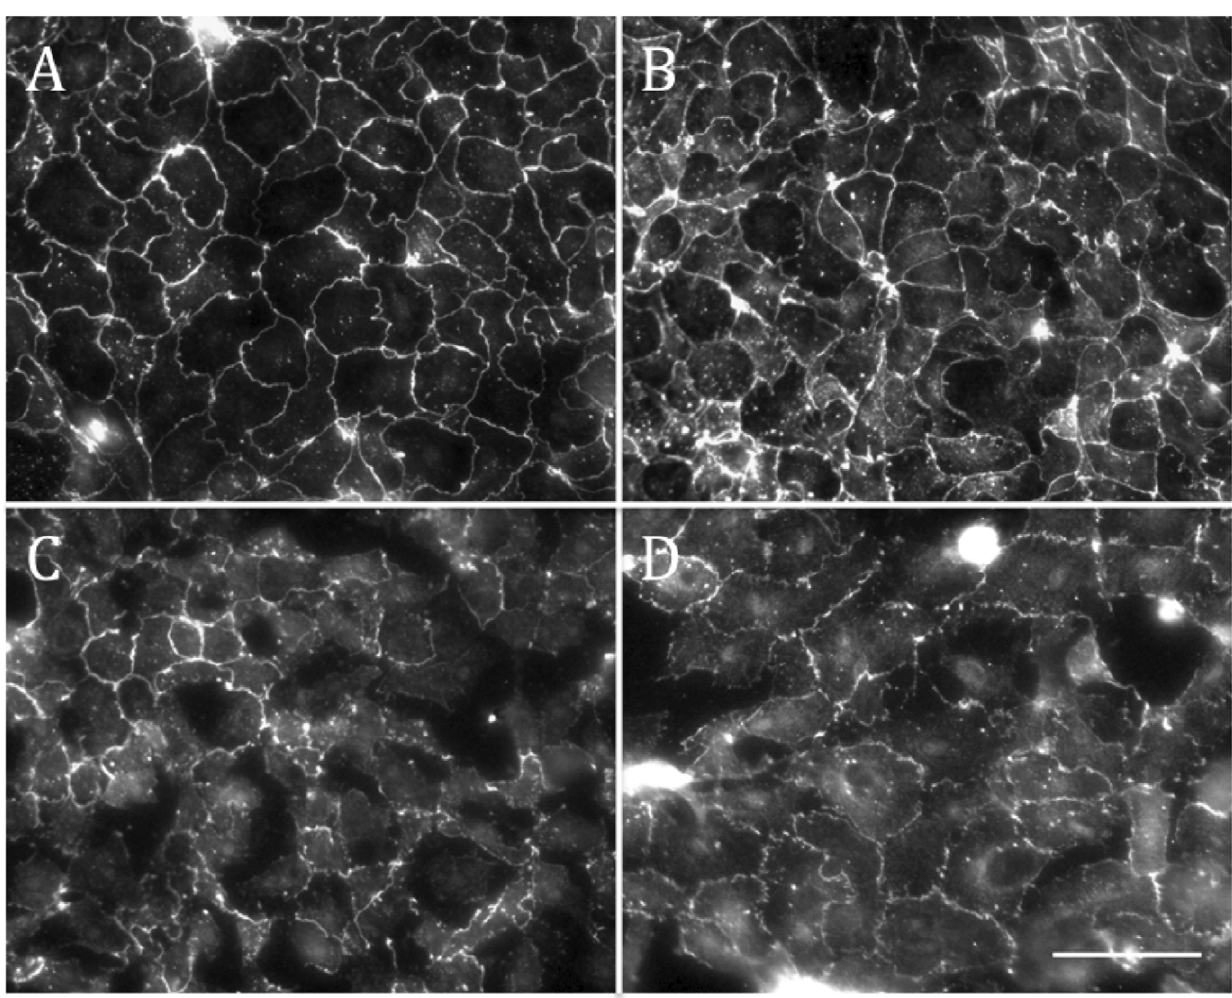
Figure 6. Occludin localization. Images of epithelial monolayers, stained with occludin antibodies, either treated with DMSO control (A and C) or SP600125 (B and D). Unstretched monolayers (A and B), exhibit strong staining of Occludin at the cell-cell junction. Following stretch, junctional staining is significantly reduced, and large holes form in the monolayer. SP600125 treatment reduces these alterations following stretch, however hole formation is still evident. (Scale bar 100 m m).